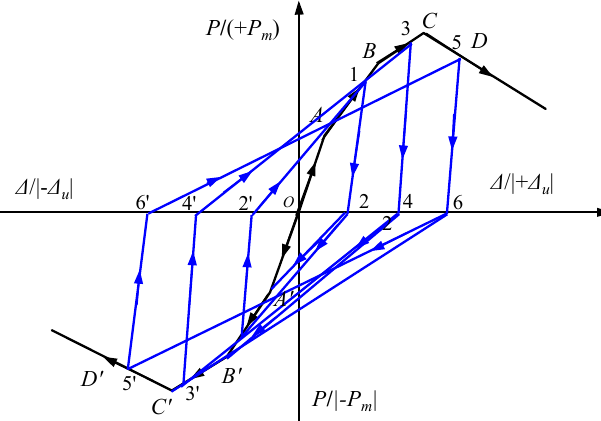
Figure 25. Four-line restoring force model of stiffness degradation.